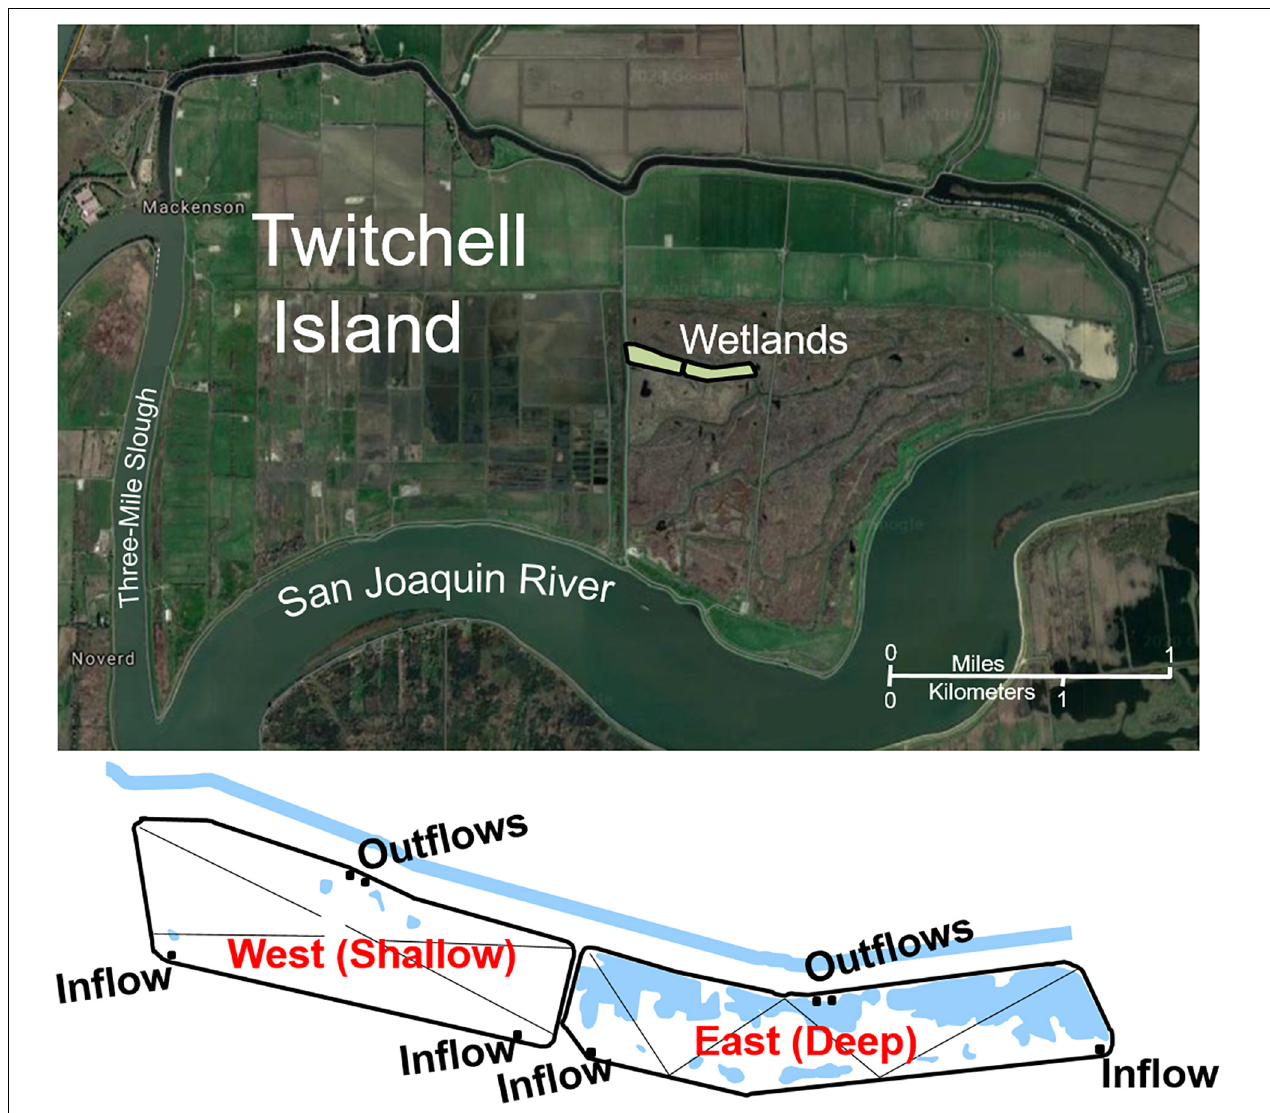
FIGURE 1 | Location of reconstructed wetlands on Twitchell Island (each 3 ha) near the confluence of the Sacramento River and San Joaquin River in Central California, reproduced from Miller et al. (2008). The west wetland was maintained at 25 cm water depth and is referred to in the text as the Shallow wetland. The east wetland was maintained at 55 cm water depth and is referred to in the text as the Deep